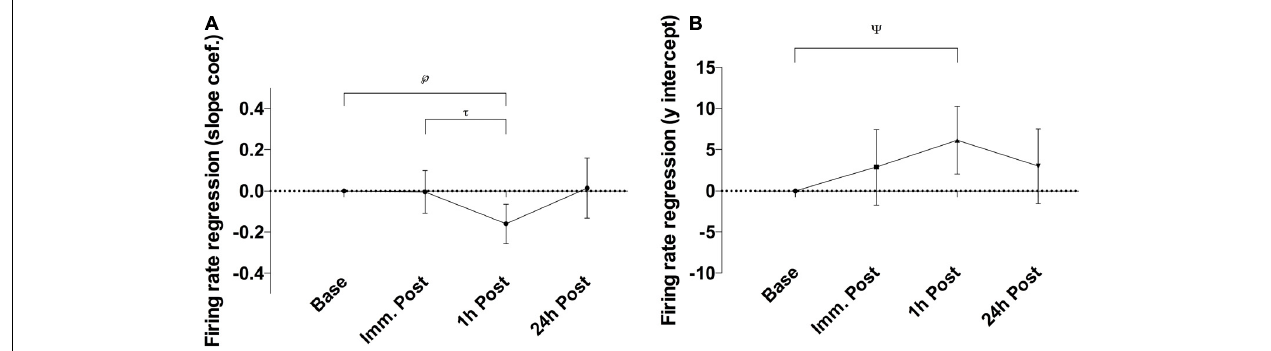
FIGURE 3 | Difference of the slope coefficient (A) and y-intercept (B) of the firing regression relative to baseline. There appeared to be negative shift in the regression following sparring, peaking at the 1 h time-point. ℘ p = 0.011; τ p = 0.008; ψ p = 0.026; error bars indicate 95% CI relative to baseline.